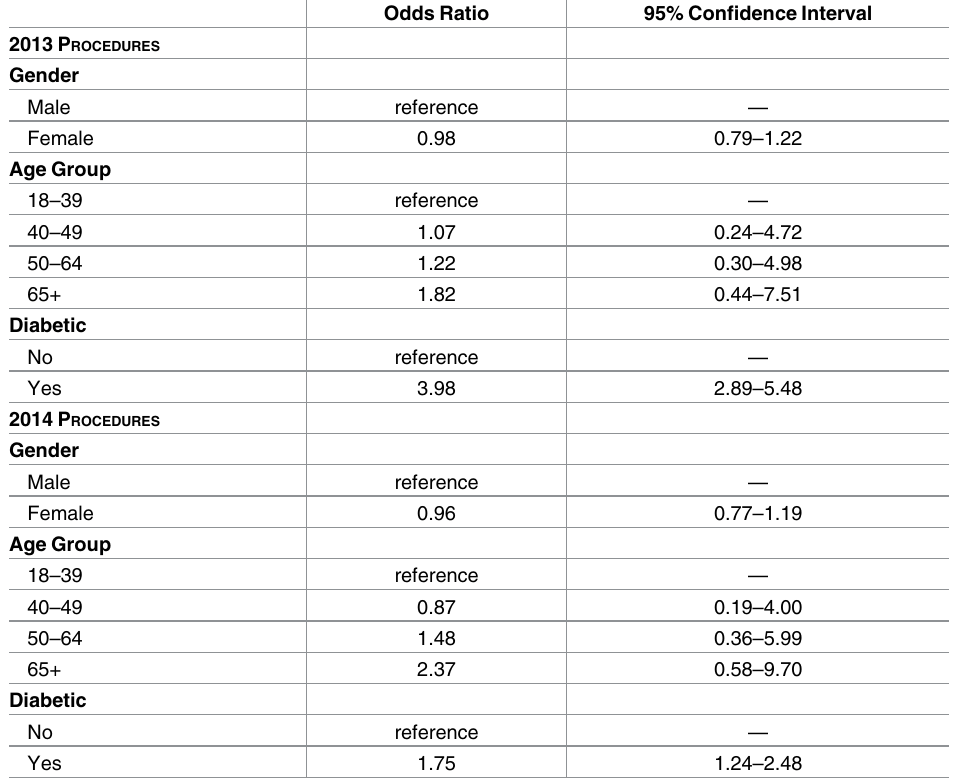
Table 3. Multivariate predictors of inadequate bowel